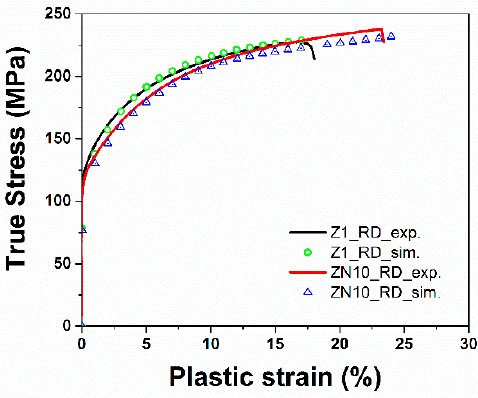
Figure 10. Experimental and simulated of true stress-plastic strain curves of Z1 and ZN10 along RD.